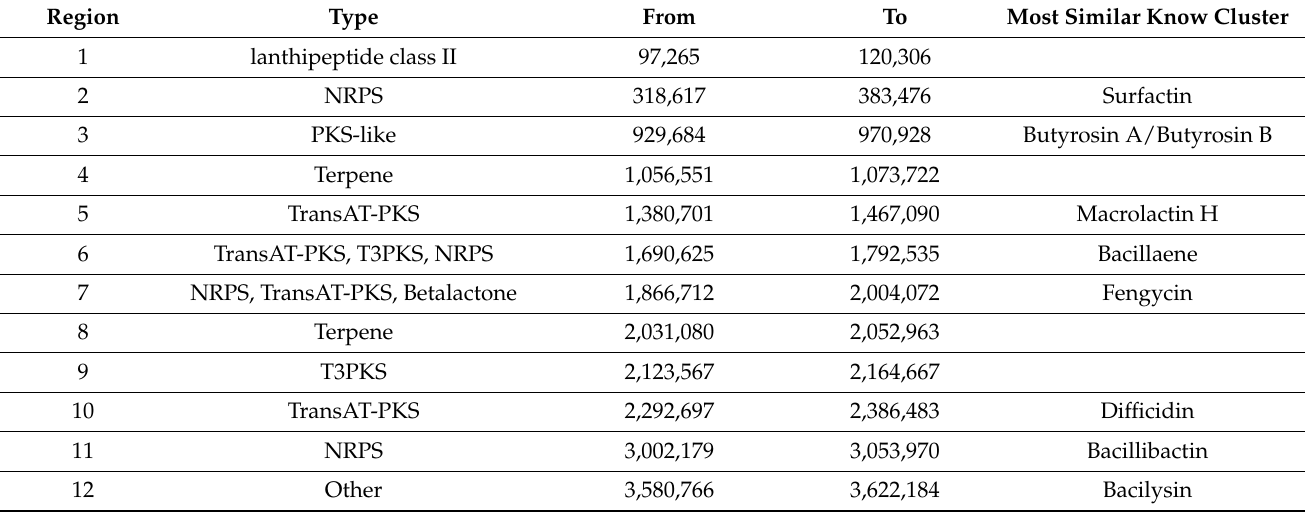
Table 4. AntiSMASH results showing all BGCs found within the B.BV10 genome and their positions, alongside with the best hit from the MiBiG database, relating the cluster to a possible product